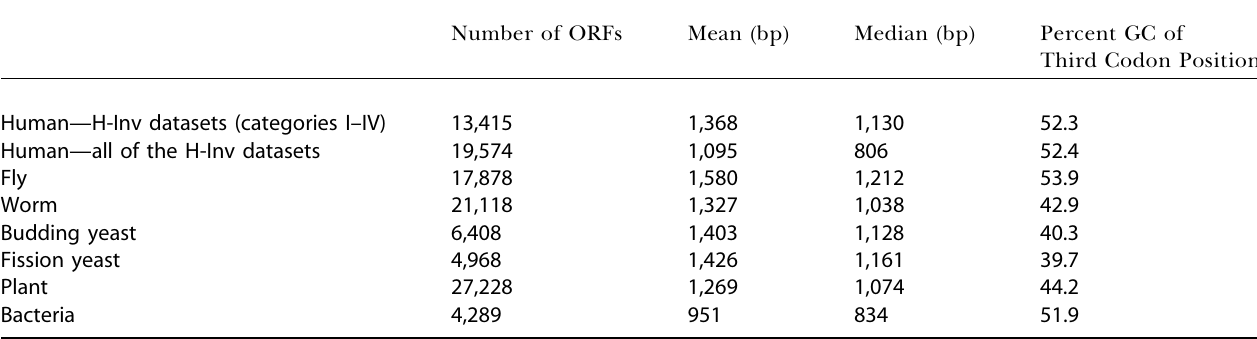
Table 4. The Features of Predicted ORFs